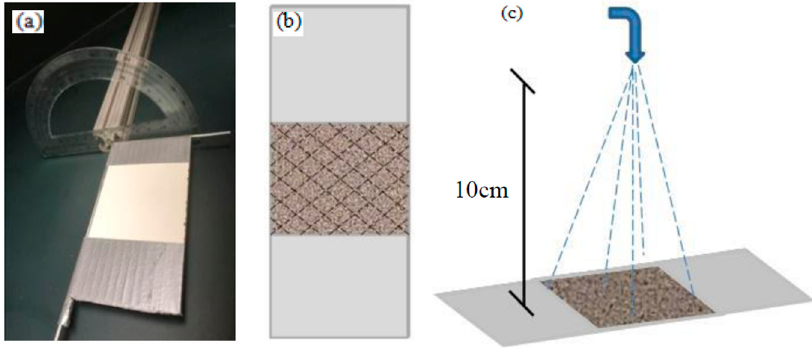
Figure 9. ( a ) Self-made slide angle measuring station; ( b ) knife-scratch and ( c ) water jet